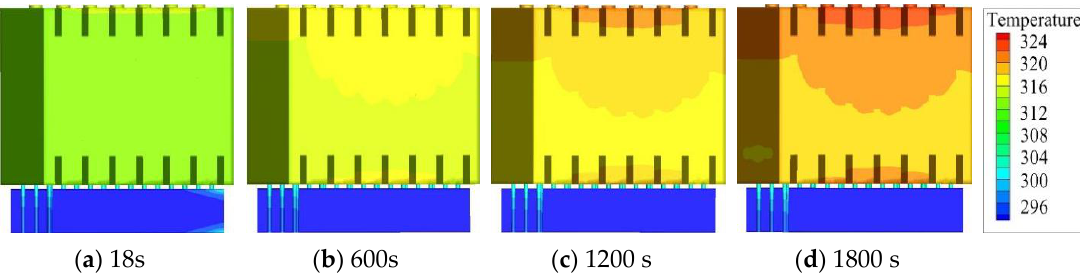
Figure 12. Comparison of temperature changes at different positions on the inlet and outlet of the water tank.